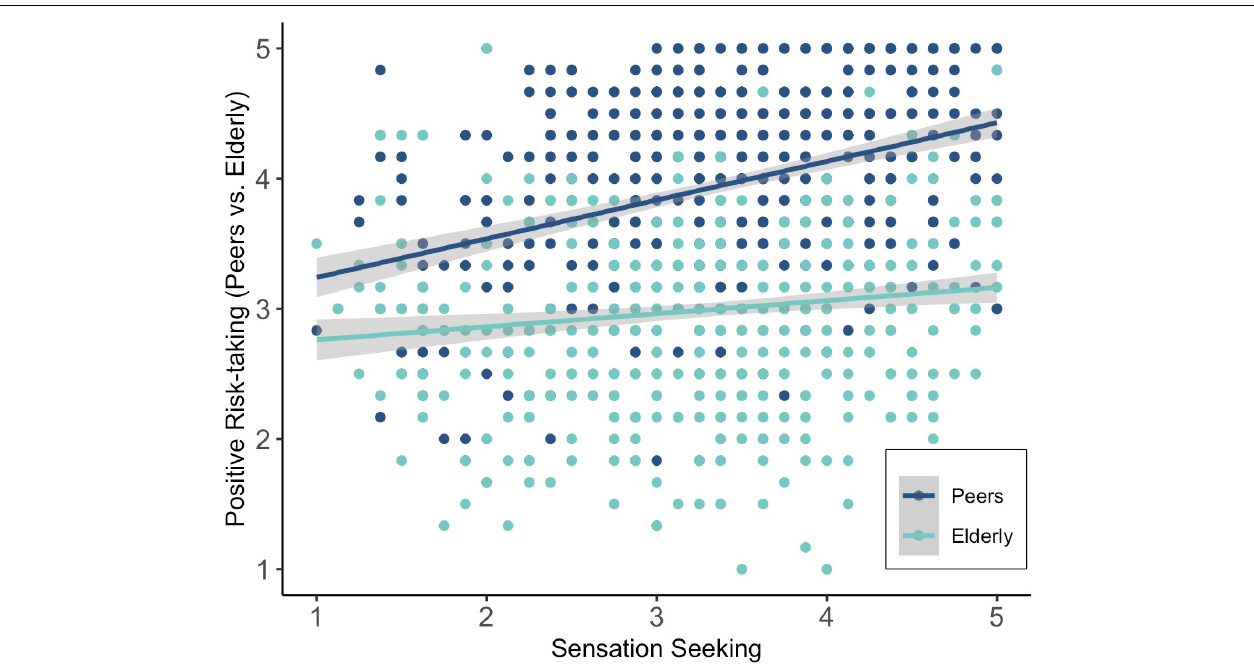
FIGURE 4 | Association between sensation seeking and positive risk-taking to peers versus elderly (i.e., non-adherence to social distancing and contract restriction), with larger differences between peers and elderly being indicative of positive risk-taking.